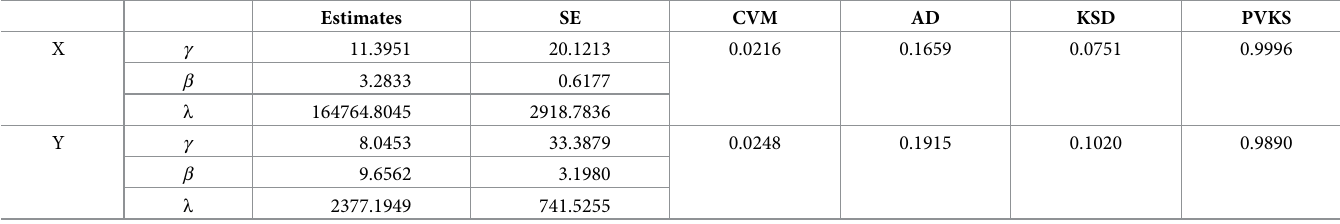
Figs 8 and 9 show the fitted CDF with empirical CDF, fitted PDF with histogram plot, and PP-plot for the duration of diabetes and serum creatinine, respectively. In Table 5 goodness of fit measures for FGM copula have been obtained as kendall, sperman, tau, rho, statistics, and copula parameter θ with P-Value is 0.1339 > 0.05, then we accept the null hypothesises as the bivariate date is fit for FGM copula. The MLE with SE, and coefficient of variation (CV) for Table 4. MLE with different measures of Goodness of fit test of marginal